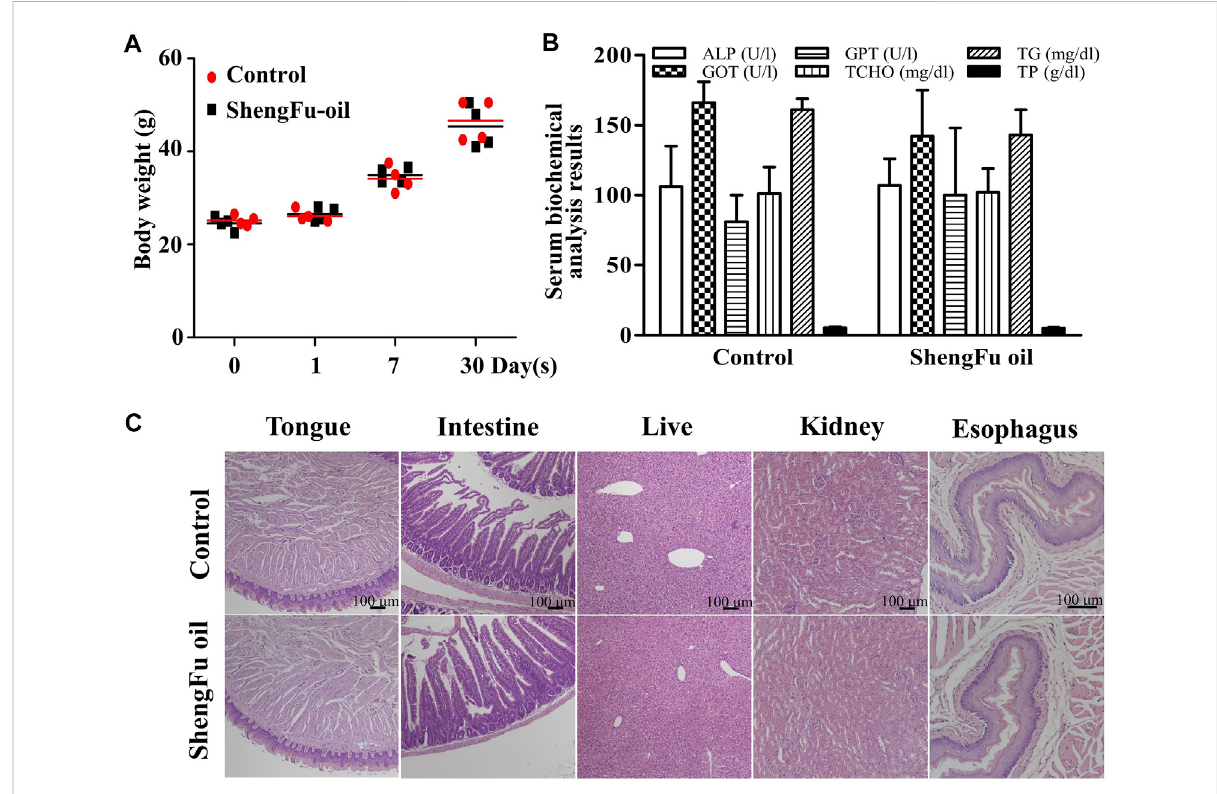
FIGURE 6 NoharmfuleffectsofShengFuoilonnormalorgansincludingtongue,esophagus,smallintestine,liver,andkidneyofmice. (A) Bodyweightgain in different groups during the experiment. (B) Serum biochemical analysis results of a 30-days safety assessment in young mice orally exposed to ShengFuoil(SFO).ThechangesinserumAST,ALT,ALP,TCHO,TG,andTPaspartateaminotransferase(AST),alanineaminotransferase(ALT),alkaline phosphatase(ALP),totalcholesterol(TCHO),thyroglobulin(TG),andtotalprotein(TP)levelsdirectly orindirectly re fl ectthedamage. Datawere presented as mean ± SEM. (C) H&E staining of tissue samples from tongue, esophagus, small intestine, liver and kidney in control and ShengFu oil